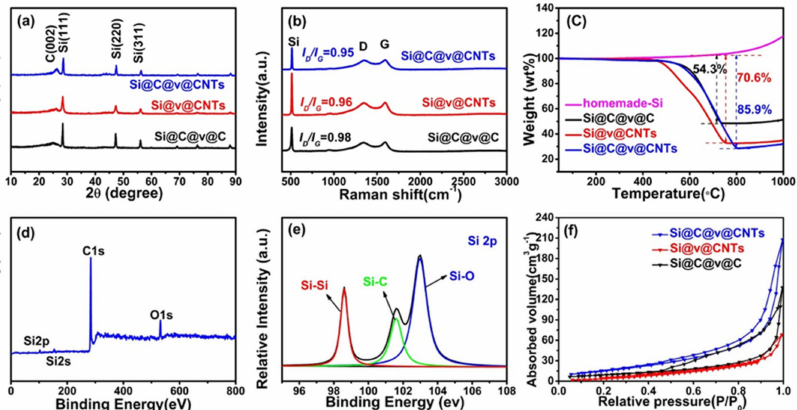
Figure 1. XRD patterns ( a ), Raman spectra ( b ), and thermogravimetric analysis (TGA)